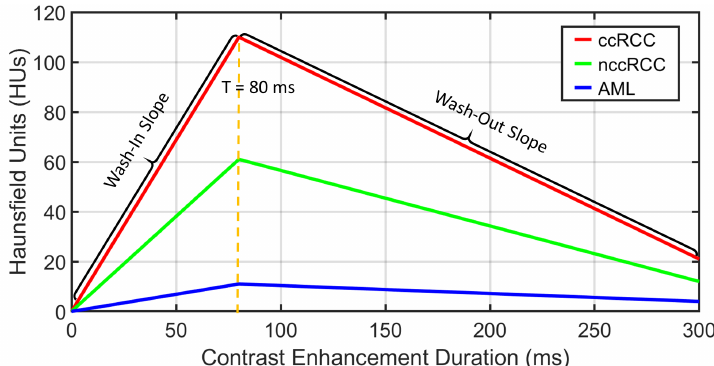
Figure 8. Example of the wash-in and wash-out slopes construction process for various types of renal tumors. When compared to nccRCC (green) and AML (blue), ccRCC tumors exhibit higher and faster wash-in/-out slopes